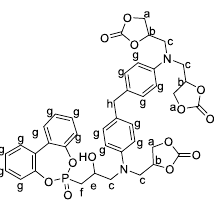
Figure 18. MBDAC-BPPO